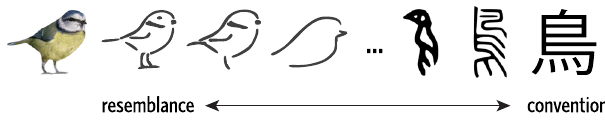
Fig. 8 | Schematic of pictorial meaning as a spectrum. Our fi ndings support the notion that both visual resemblance and socially mediated conventions jointly guideinferencesaboutpictorialmeaning.Leftmostcolorimagewasrenderedfrom 3D mesh model licensed by